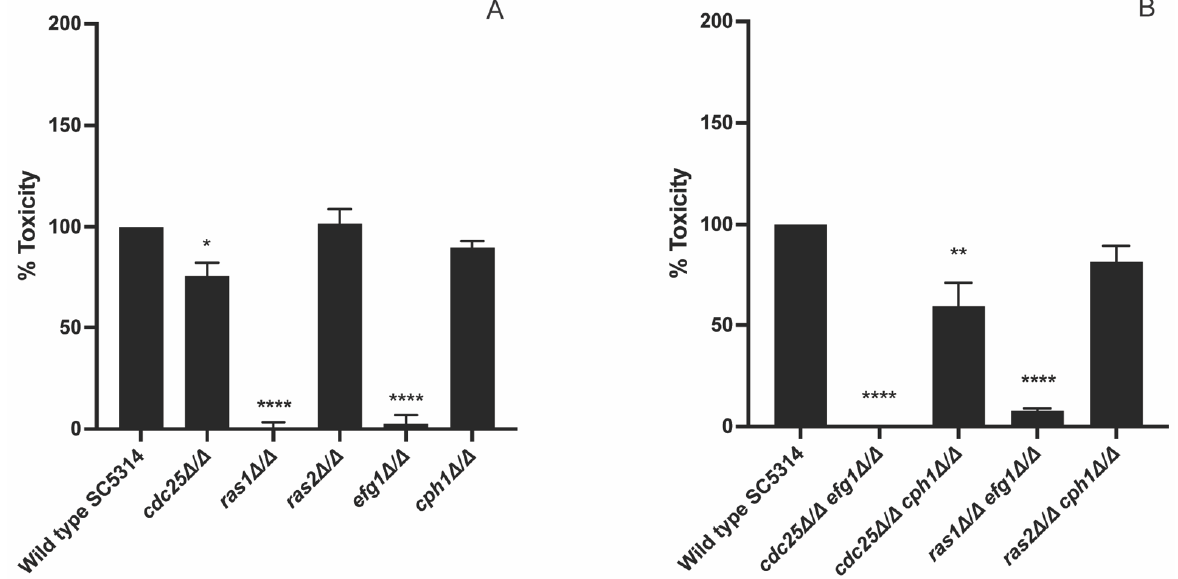
Figure 5. The Ras1/PKA pathway seems to be involved in toxicity towards oral epithelial cells. TR146 cells were seeded at a concentration of 10,000 cells/well. C. albicans cells were added at OD 600 0.1. After an incubation of 24 h, the released amount of LDH from the TR146 cells was measured. ( A ) The toxicity of the WT was compared with a cdc25 , ras1 , ras2 , efg1 , and cph1 mutant. ( B ) The toxicity of the WT was compared with a cdc25 efg1 , cdc25 cph1 , ras1 efg1 , and ras2 cph1 double mutant. The values of the deletion strains are normalized relative to the WT strain which has 100% toxicity towards TR146 cells. The results show the average of three independent experiments each consisting of one biological repeat and three technical repeats with the error bars representing the SEM. Statistical analysis was done by using an ANOVA test with Bonferroni correction. A significant difference was found when * p = 0.0332, ** p = 0.0021, and **** p < 0.0001.